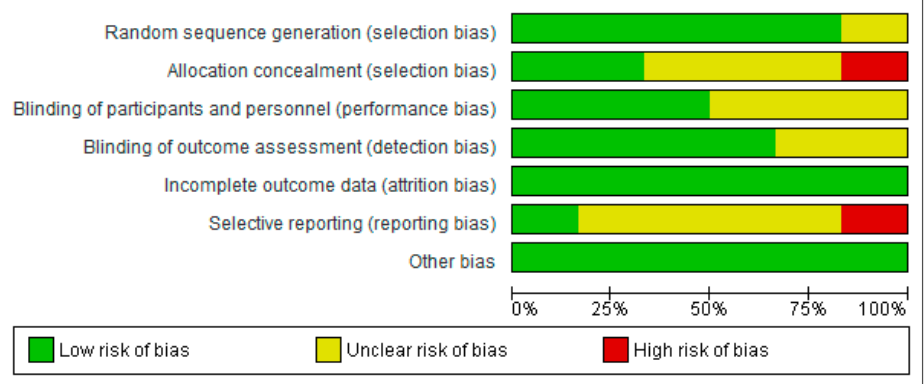
Figure 3. Risk of bias summary [19–24]. 3.4. Risk of Bias among Studies The bias among studies in this review was classified as unclear, as most of the infor- mation comes from studies with unclear risk of bias. 3.5. Results of Individual Studies In total, from the 6 trials included in this review [19–24], 519 implants were placed in 247 living humans and 8 human cadaver heads (in the upper jaw). Of these, 192 were placed freehand (180 in living humans and 12 in human cadaver heads) and 327 in a guided manner (315 in living humans and 12 in human cadaver heads). Within the guided surgery, 43 implants were placed by dynamic surgery and the other 284 by static surgery (124 fully guided, 63 partially guided and 97 by pilot-drill sur- gery). Regarding the techniques used to place the dental implants, in the six included stud- ies [19–24], implants were placed by freehand surgery in the control group. This freehand